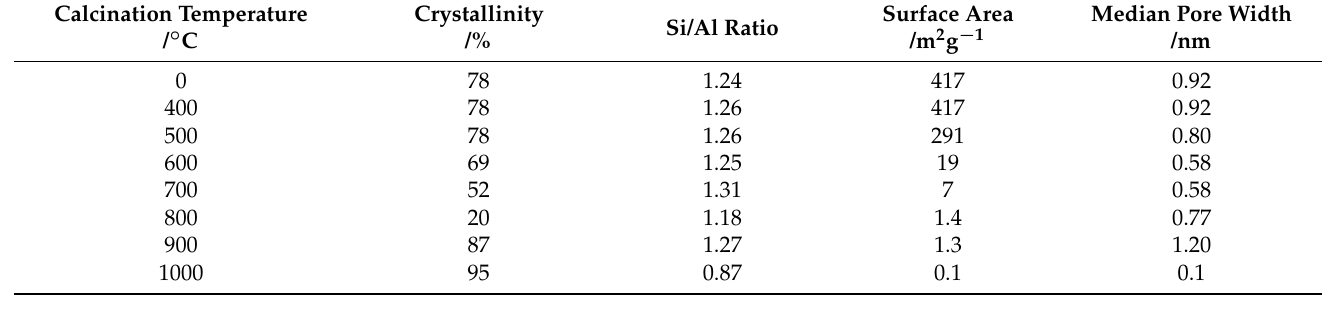
Table 1. Crystallinity, Si/Al ratio, surface area, and median pore width of the synthesized LTX catalyst after calcination at different temperatures.